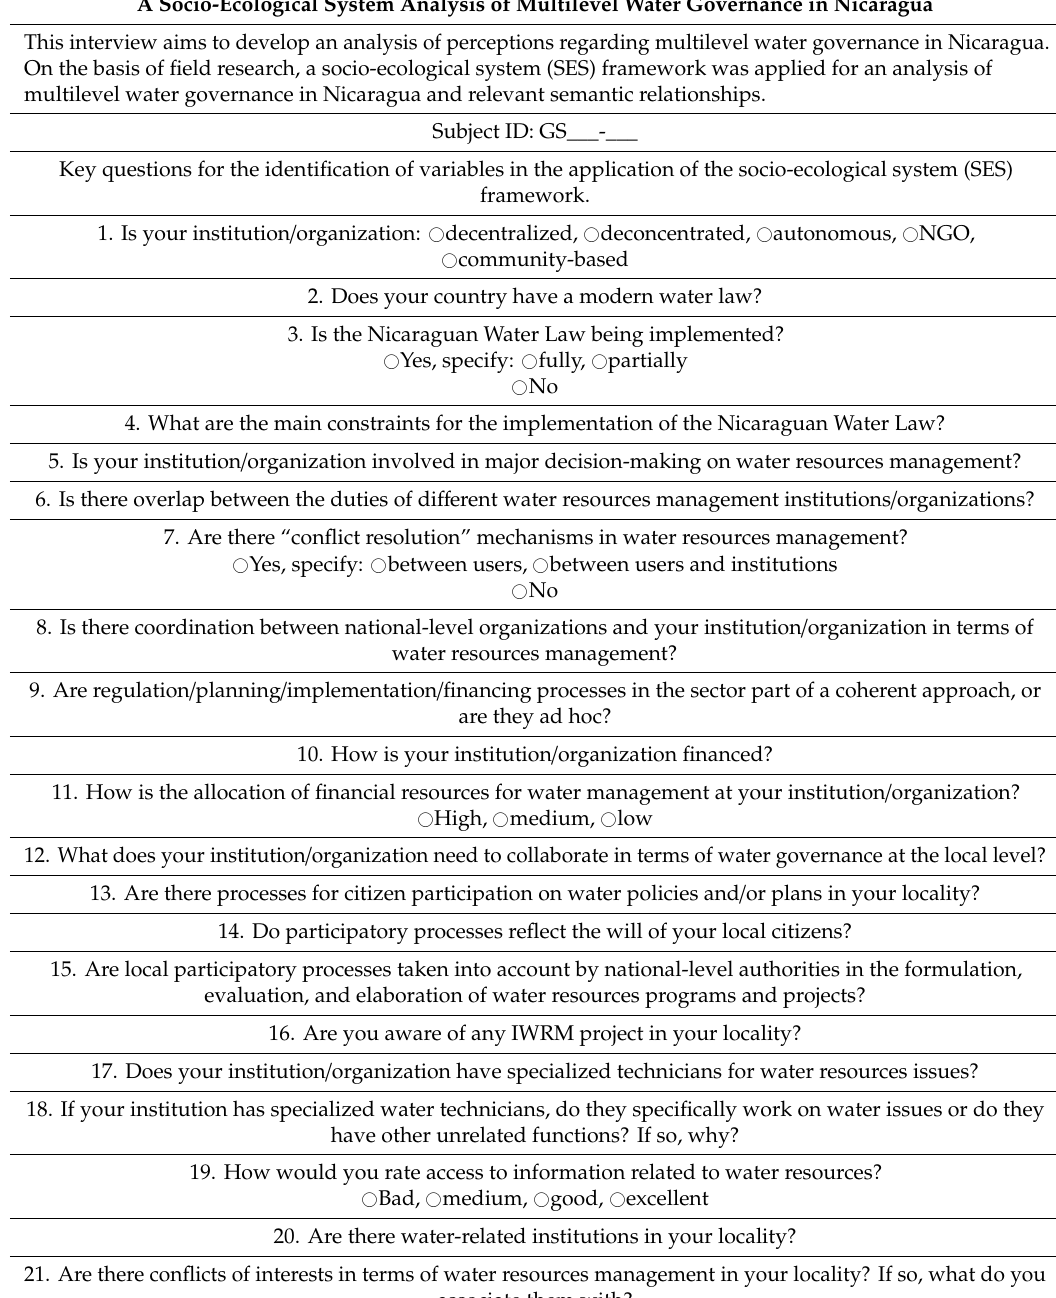
Table A1. Model of a semistructured